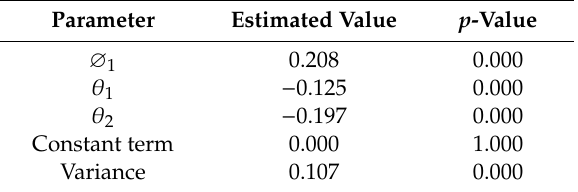
Figure 5. Differentiated output with ACF and PACF analysis. Figure 5. Di ff erentiated output with ACF and PACF analysis. Table 1. Autoregressive moving average (ARMA) model Parameters. Table 1. Autoregressive moving average (ARMA) model Parameters.